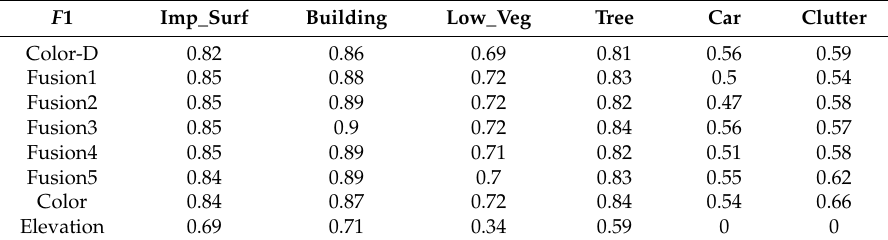
Table 4. Class-wise F 1 score of six classes for dataset Vaihingen.